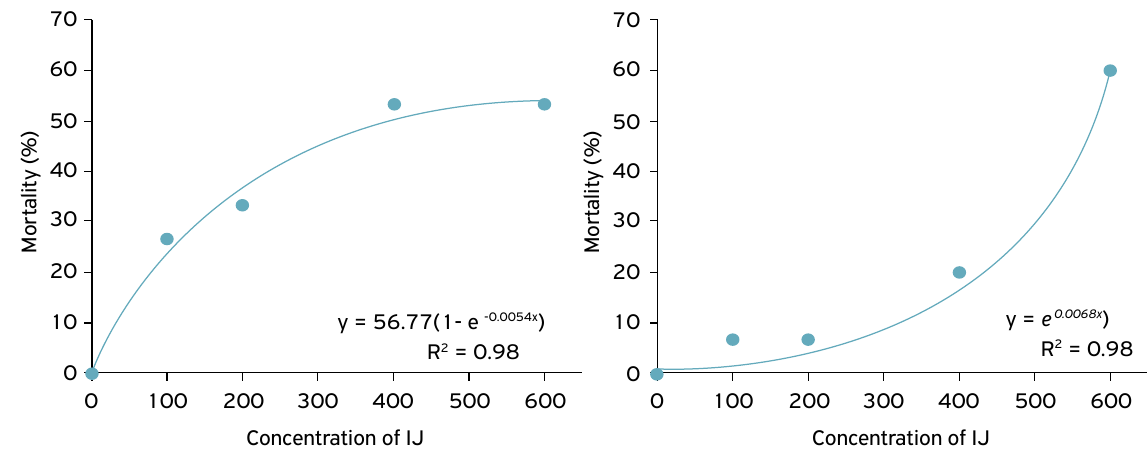
Figure 1. Mortality of Gryllus sp. as a function of the concentration of infective juveniles (IJ) of (A) Heterorhabditis amazonensis MC01 and (B) Steinernema